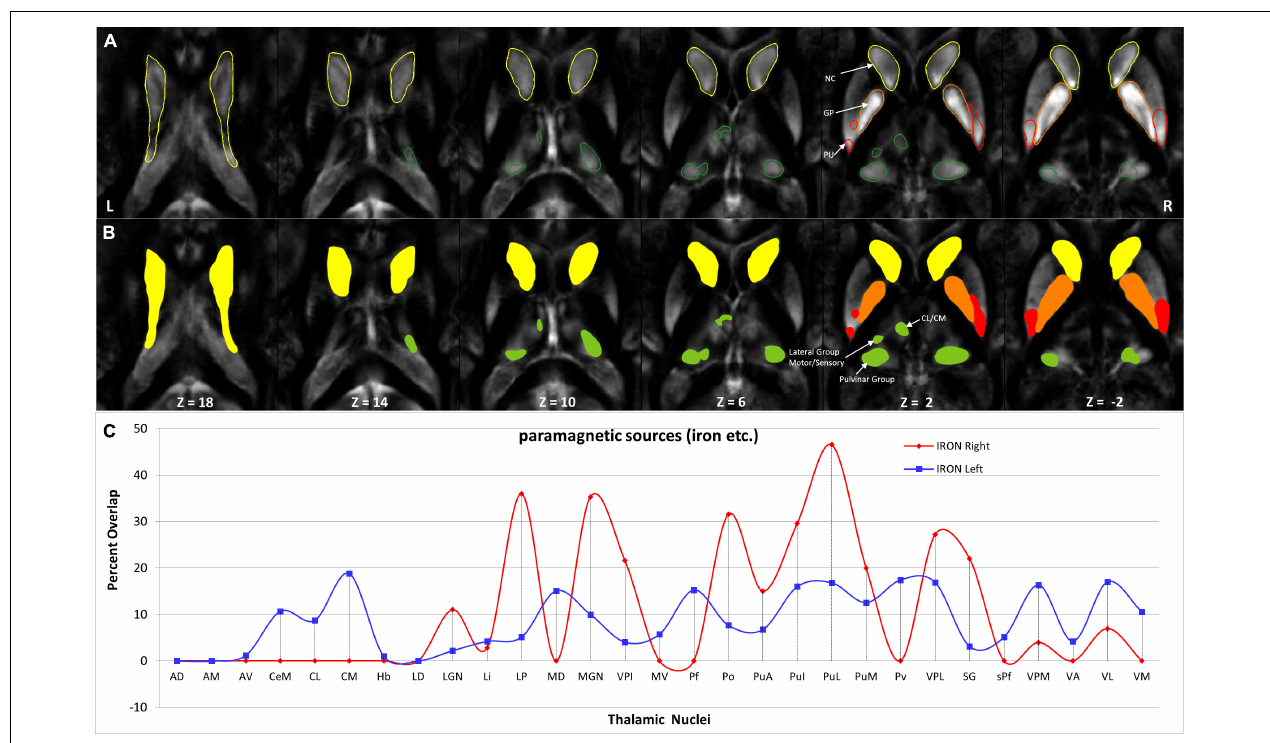
FIGURE 11 | Depiction of value ( > 20) of paramagnetic sources in Th and BG: (A) Outline depiction of the paramagnetic parcel with mean values > 20 for the caudate (yellow), putamen (red), pallidum (orange), and Th (green). Note that the striatum (pallidum and caudate) encircle most of their structure above the threshold. (B) Colored version of the first row illustrates higher value regions. (C) Calculated overlap with the Thatlas shows higher values in the nuclei of the posterior Th (Po, PuA, Pul, and PuL), the relay nuclei (MGN, VPI, VPL, VPM, and VL), and the high-order intralaminar nuclei (CL and